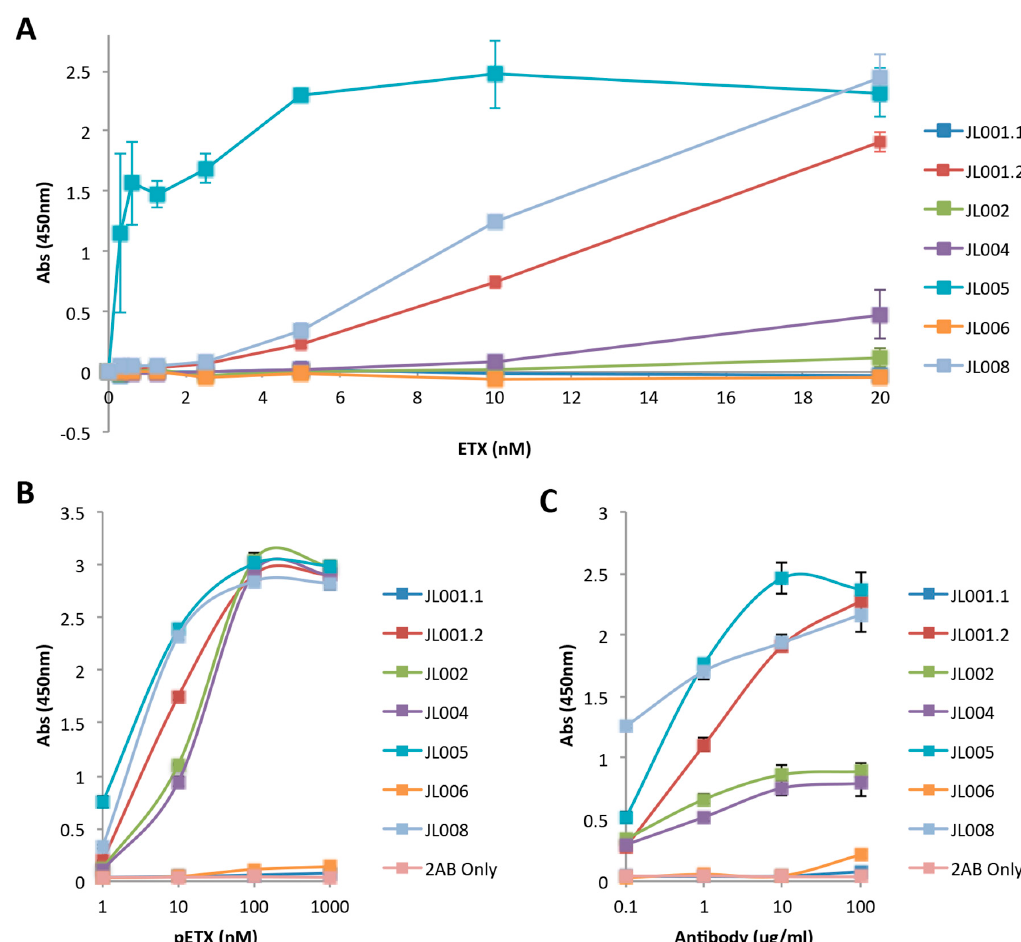
Figure 3. Detection of ETX via indirect ELISA. ( A ) ELISA plates were incubated with indicated amounts of ETX and then probed with 1 µ g/mL of indicated anti-ETX monoclonal antibody. Displayed results are adjusted for background absorbance. ( B ) ELISA plates were coated with indicated amounts of pETX and probed with 1 µ g/mL of the specified anti-ETX monoclonal. ( C ) Alternatively, ELISA plates were coated with 10 nM pETX and probed with the specified concentrations of anti-ETX antibodies. Wells probed with peroxidase-conjugated anti-rabbit antibody only (2AB Only) were used as negative controls. Results are mean ± SD.